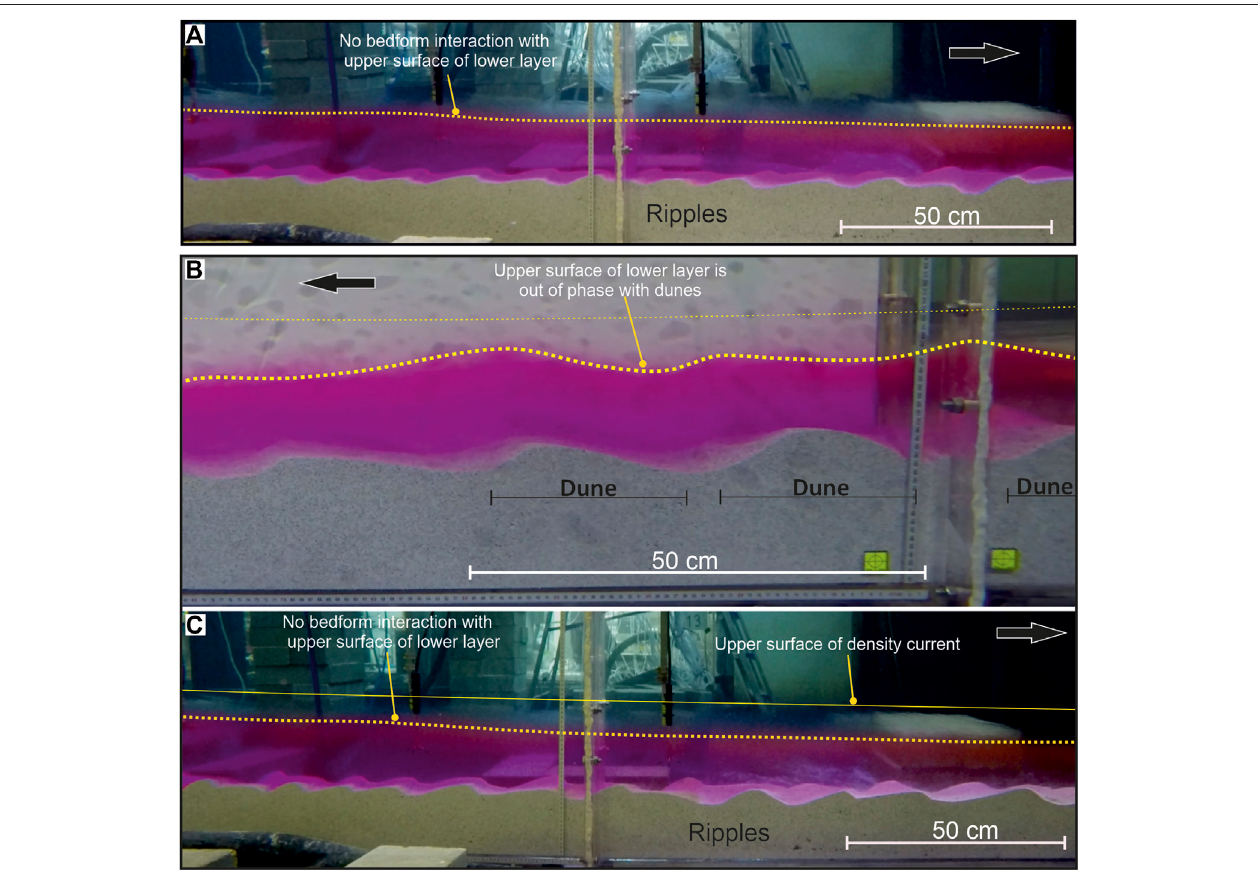
FIGURE 8 | Bedform current interaction. Two layers can be recognized in the density current: the lower denser layer of the density current is dyed red/pink, the upper surface of the lower denser layer is indicated by a yellow dotted line. The current interface with ambient water is indicated by a solid yellow line. Direction of fl ow is indicated by an arrow in each photograph. (A) There is no interaction between ripples and the lower layer upper surface (Experiment 3). (B) Dune bedforms formed towardtheendofExperiment5.Thedunesareout-of-phasewiththeuppersurfaceofthelowerlayer.Fromphoto (A) itishardtodeterminetheheightoftheupper surface of the current. (C) is taken from another fl ume angle during Experiment 3 in which the upper surface of the current can be distinguished.